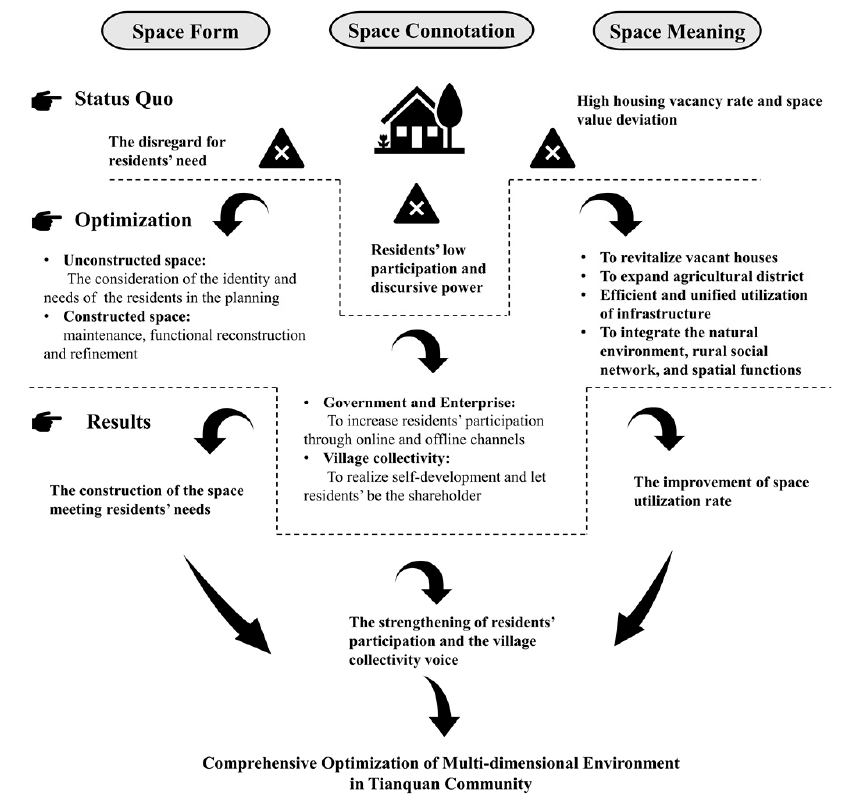
Figure 12. The optimization path of multi-dimensional environment in Tianquan Community.